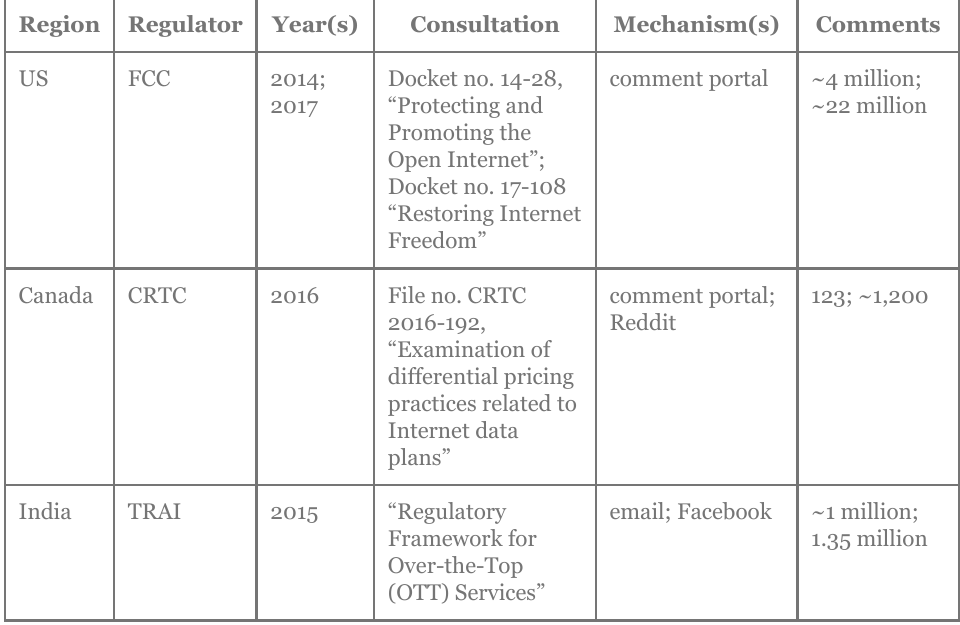
Table 1: Four examples of recent net neutrality consultation